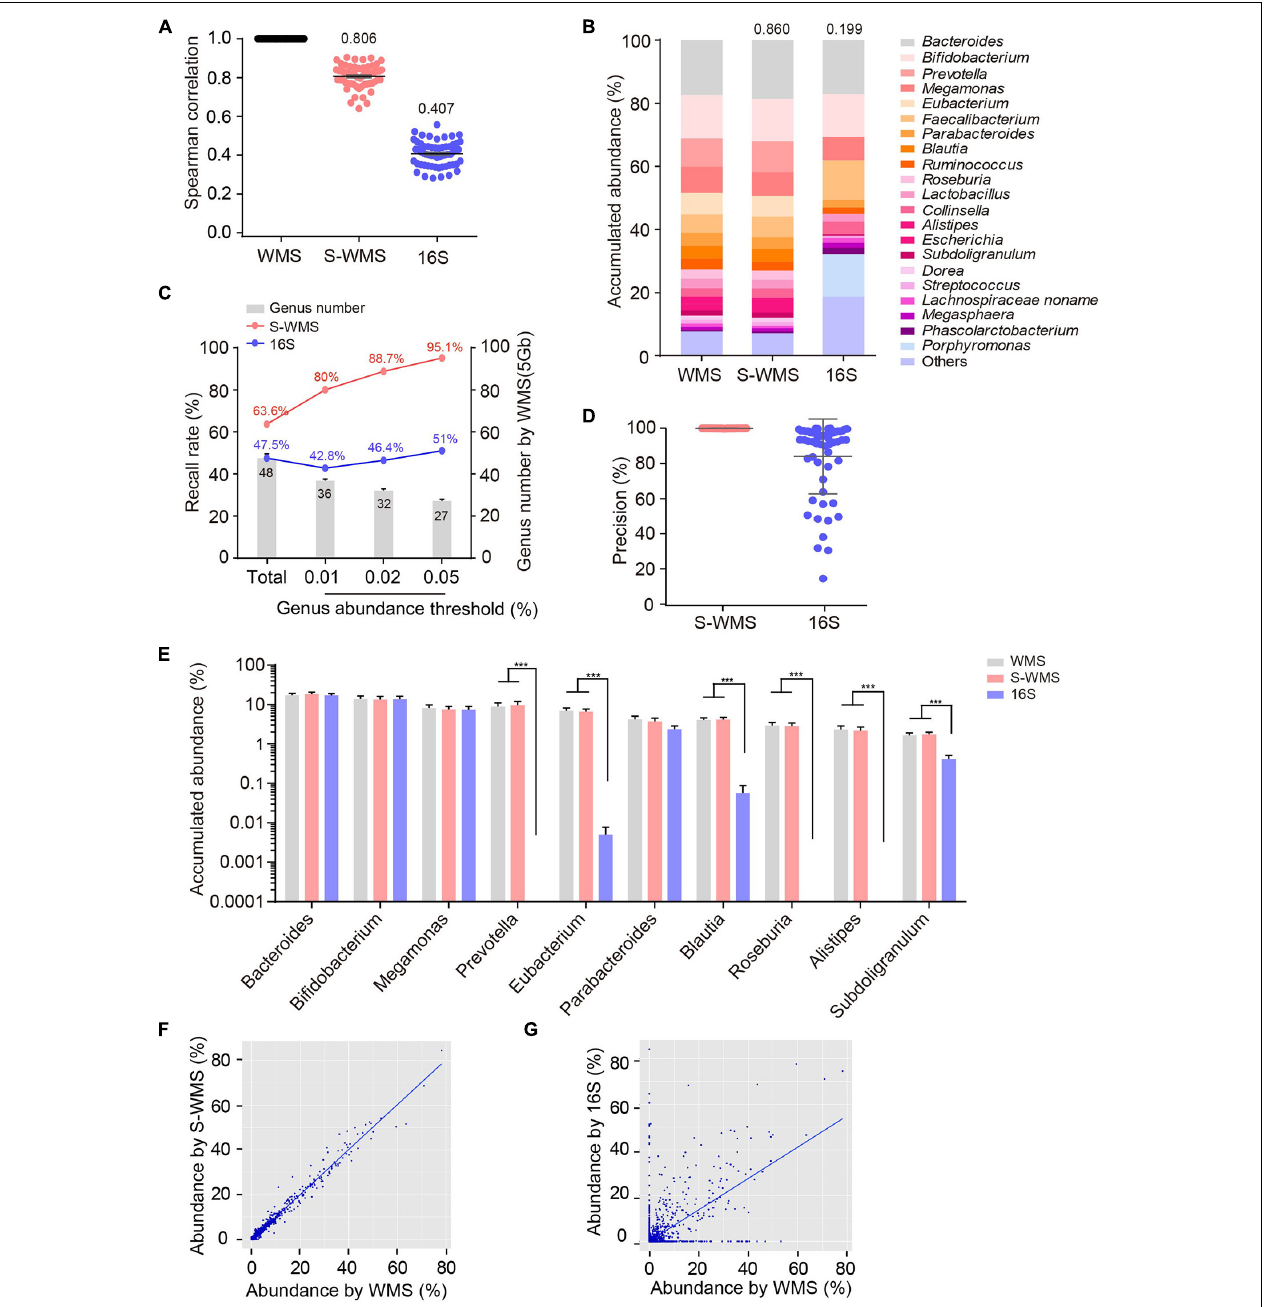
FIGURE 2 | Comparison of genus profiling of human fecal samples by classical WMS, S-WMS, and 16S. (A) Spearman correlation coefficient between 16S/S-WMS and WMS results. The values of correlation coefficient from 59 samples are shown on top of the scatter plots. (B) Stacked bar plot of genera abundance. The values on top of the bar graph indicated the Spearman correlation coefficient between 16S/S-WMS and WMS results. (C) Genus recall rate increased with a higher genus abundance threshold. (D) Data precision to WMS results. Precision: the number of correctly matched reads with WMS/the total number of obtained reads. (E) Abundance quantification of key genera. (F,G) Scatterplot of relative abundances of genera determined by S-WMS or 16S versus classical WMS. The metagenomes of 59 human stool samples were sequencing by classical WMS (5 Gb depth), S-WMS (1 Gb depth), or 16S with the WMS as reference. *** p <